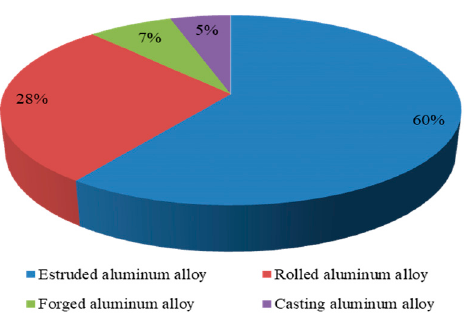
Figure 3. Aluminum proportional distribution for aviation (mass fraction, %) [9].